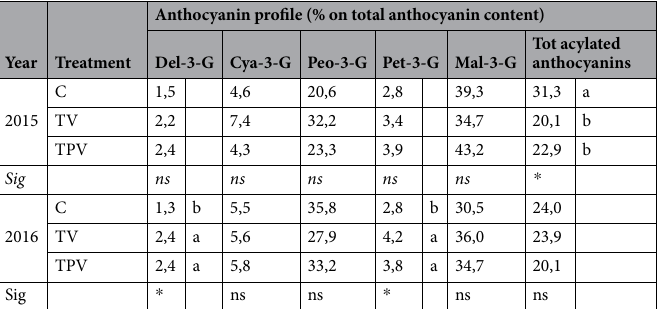
Table 2. Mean values of individual and total acylated anthocyanins, in Corvina berry skins at harvest in 2015 and 2016, for treated vines and the control. Data are expressed as % on the total anthocyanin content. Means